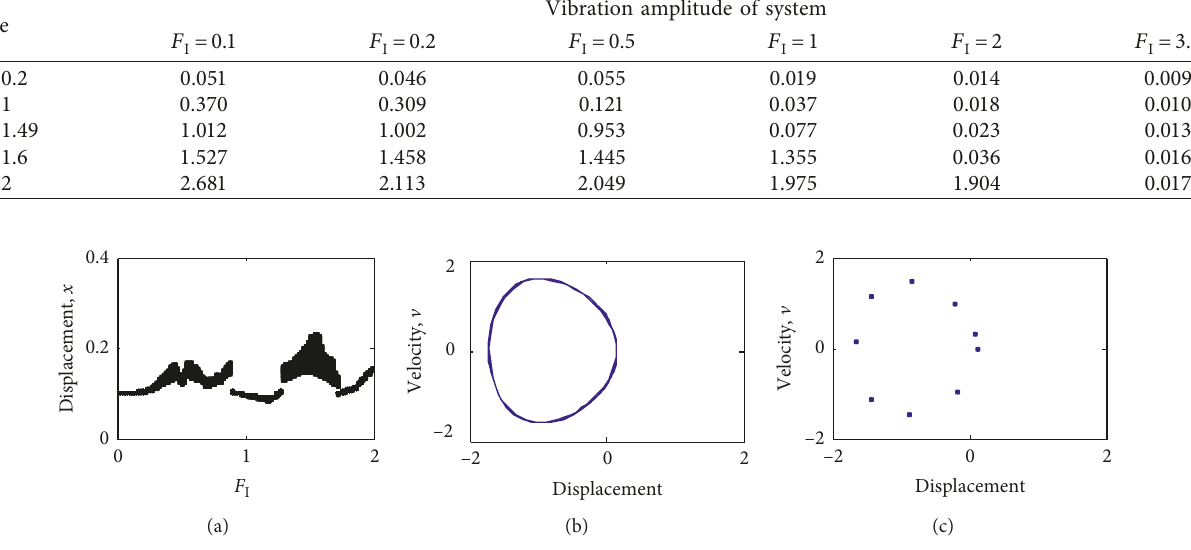
Figure 15: Dynamic response of the system. (a) Bifurcation diagram. (b) Phase diagram. (c) Poincar´e